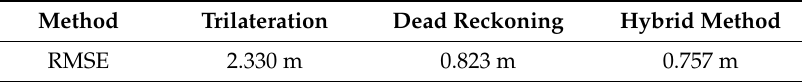
Table 5. The root-mean-square-error (RMSE) of the three